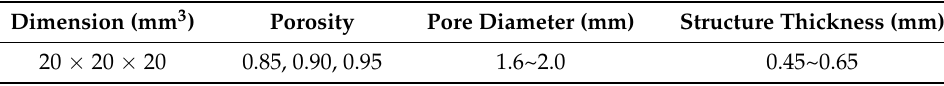
Figure 1. Original and reconstructed copper foam. Table 1. Geometrical parameters of the porous model.